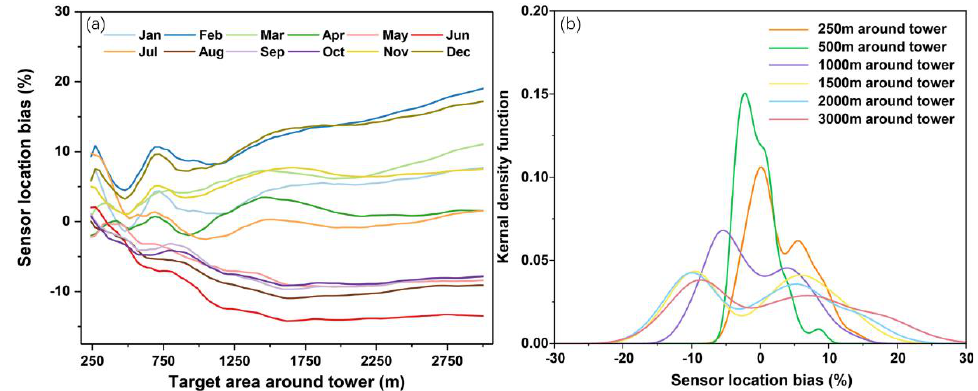
Figure 8. Sensor location bias of EVI (EVI bias ) for different months ranging from 30 to 3000 m ( a ) and kernel density distribution of the multi-year averaged EVI bias for circles in 250 m, 500 m, 1000 m, 1500 m, 2000 m and 3000 m ( b ).